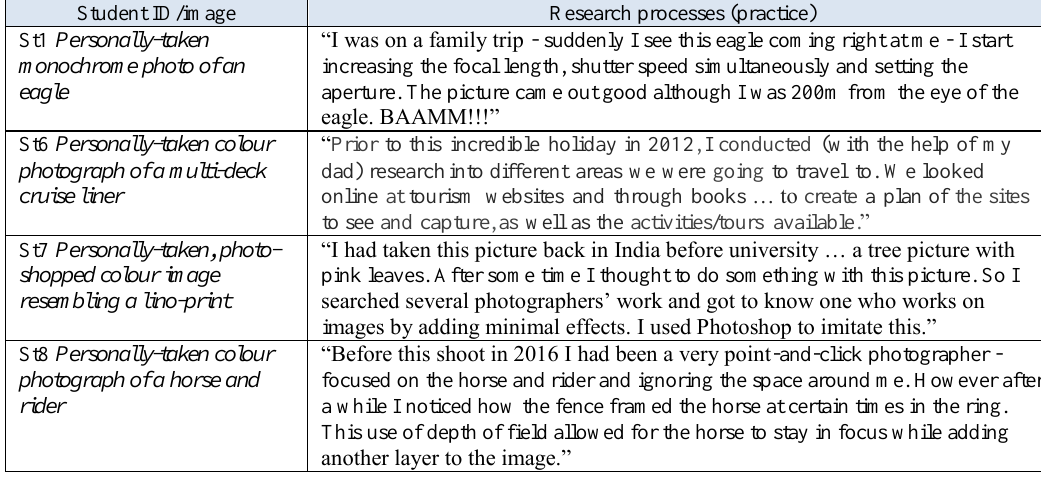
Illustrative extracts describing pre-university research processes (Theme 3): Practice Student ID/image Research processes